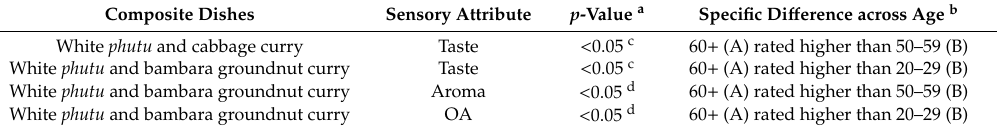
Table 9. Significant di ff erences in the acceptability ratings of composite dishes across age groups.